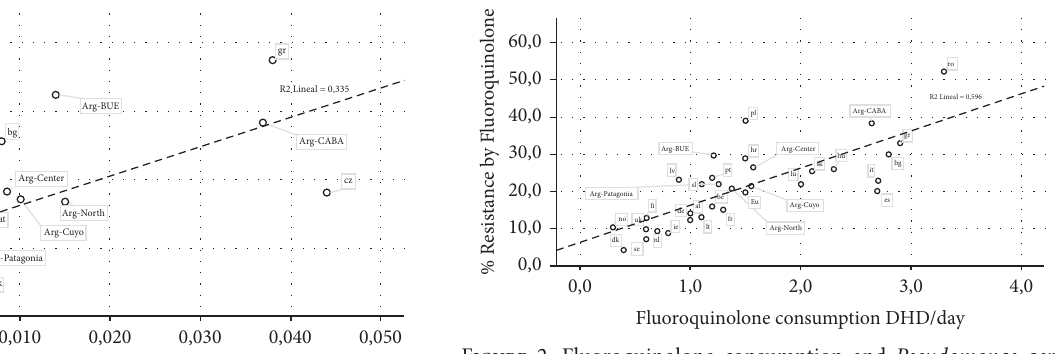
Figure 2: Fluoroquinolone consumption and Pseudomonas aer- uginosa resistance data (according to Argentinian region compared with European countries). Countries are named with their official country codes